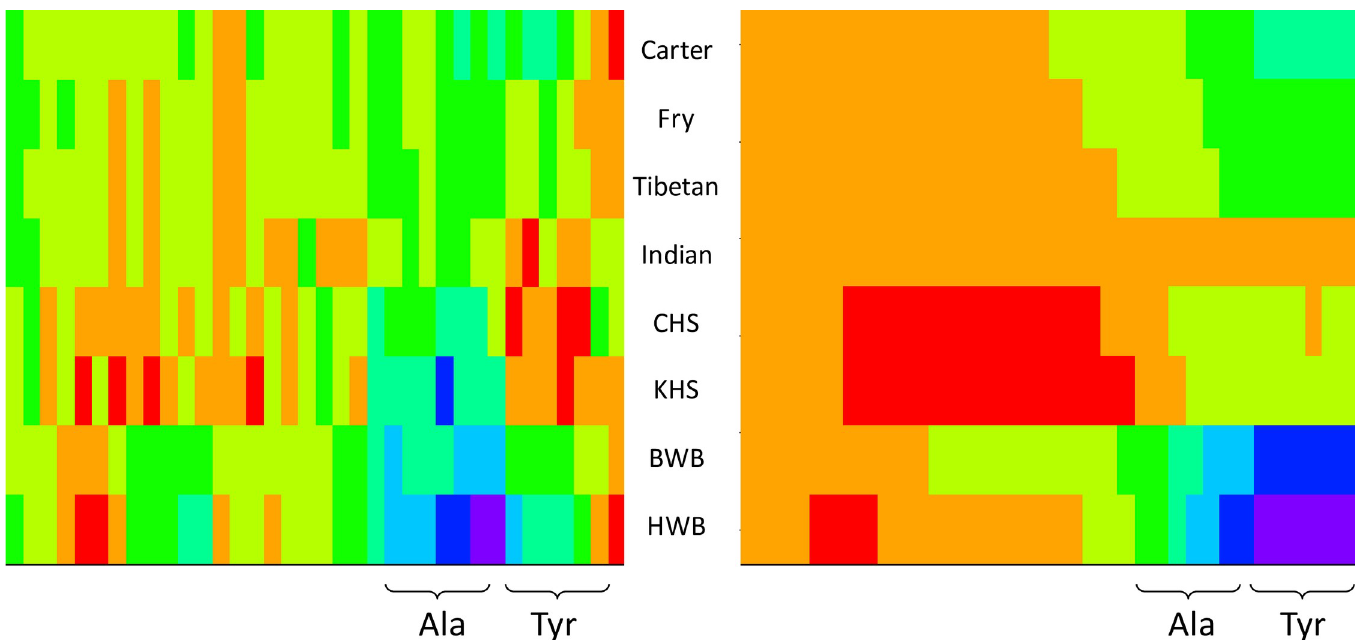
Fig 10. Heatmaps of Δ 13 C CARBOXYL isotope spacings (‰) between 36 unique pairs of NEAA for the 8 study samples; (A) individual spacings and, (B) cumulative spacings. Spacings from left-to-right; Asp-Cys, Asx-Arg, Asx-Ser, Asx-Glu, Arg-Glu, Gly-Ser, Arg-Ser, Glx-Ser, Arg-Gly, Asp–Gly, Glx–Cys, Glx–Gly, Cys-Ser, Cys-Gly, Arg-Cys, Pro-Glu, Pro-Ser, Asx-Pro, Pro-Arg, Pro-Cys, Pro-Gly, Ala-Glx, Ala-Ser, Ala-Pro, Ala-Asx, Ala-Arg, Ala-Cys, Ala-Gly, Ala-Tyr, Glx-Tyr, Pro-Tyr, Asx-Tyr, Arg-Tyr, Cys- Tyr, Tyr-Gly, Tyr-Ser.